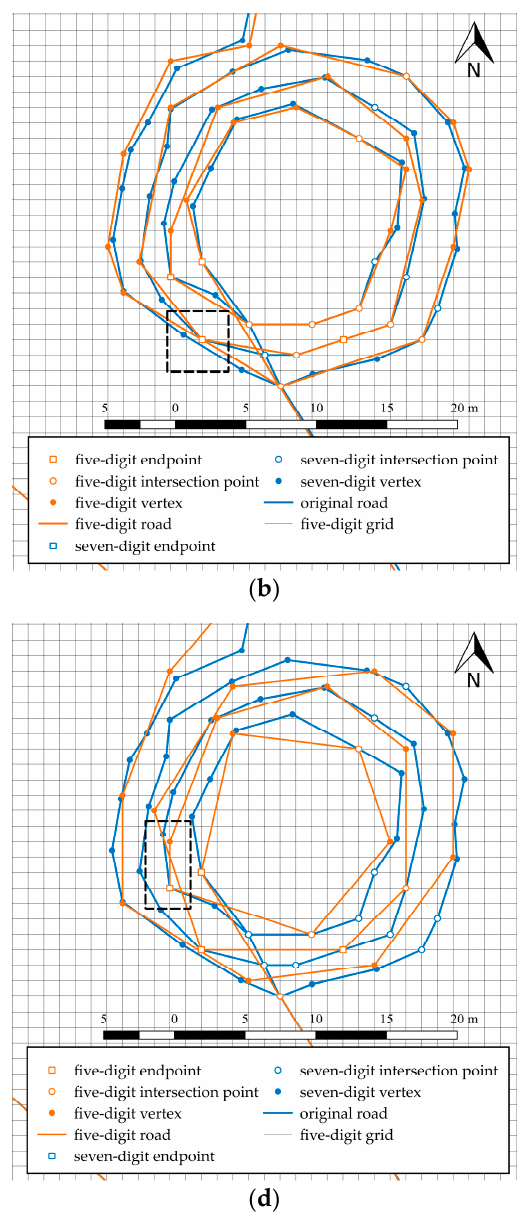
Figure 17. Simplified results of di ff erent algorithms: ( a ) improved Opheim; ( b ) DP; ( c ) VW, and ( d ) Opheim